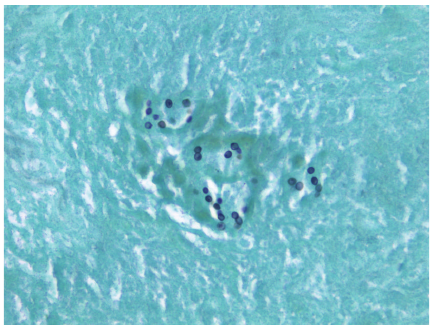
Figure 6: Microscopy 800x magnification: Gomori methenamine silver stain demonstrating classic Pneumocystis jirovecii cysts (cup- shaped with central dark zone, 5–7 𝜇 m) embedded within granu- loma